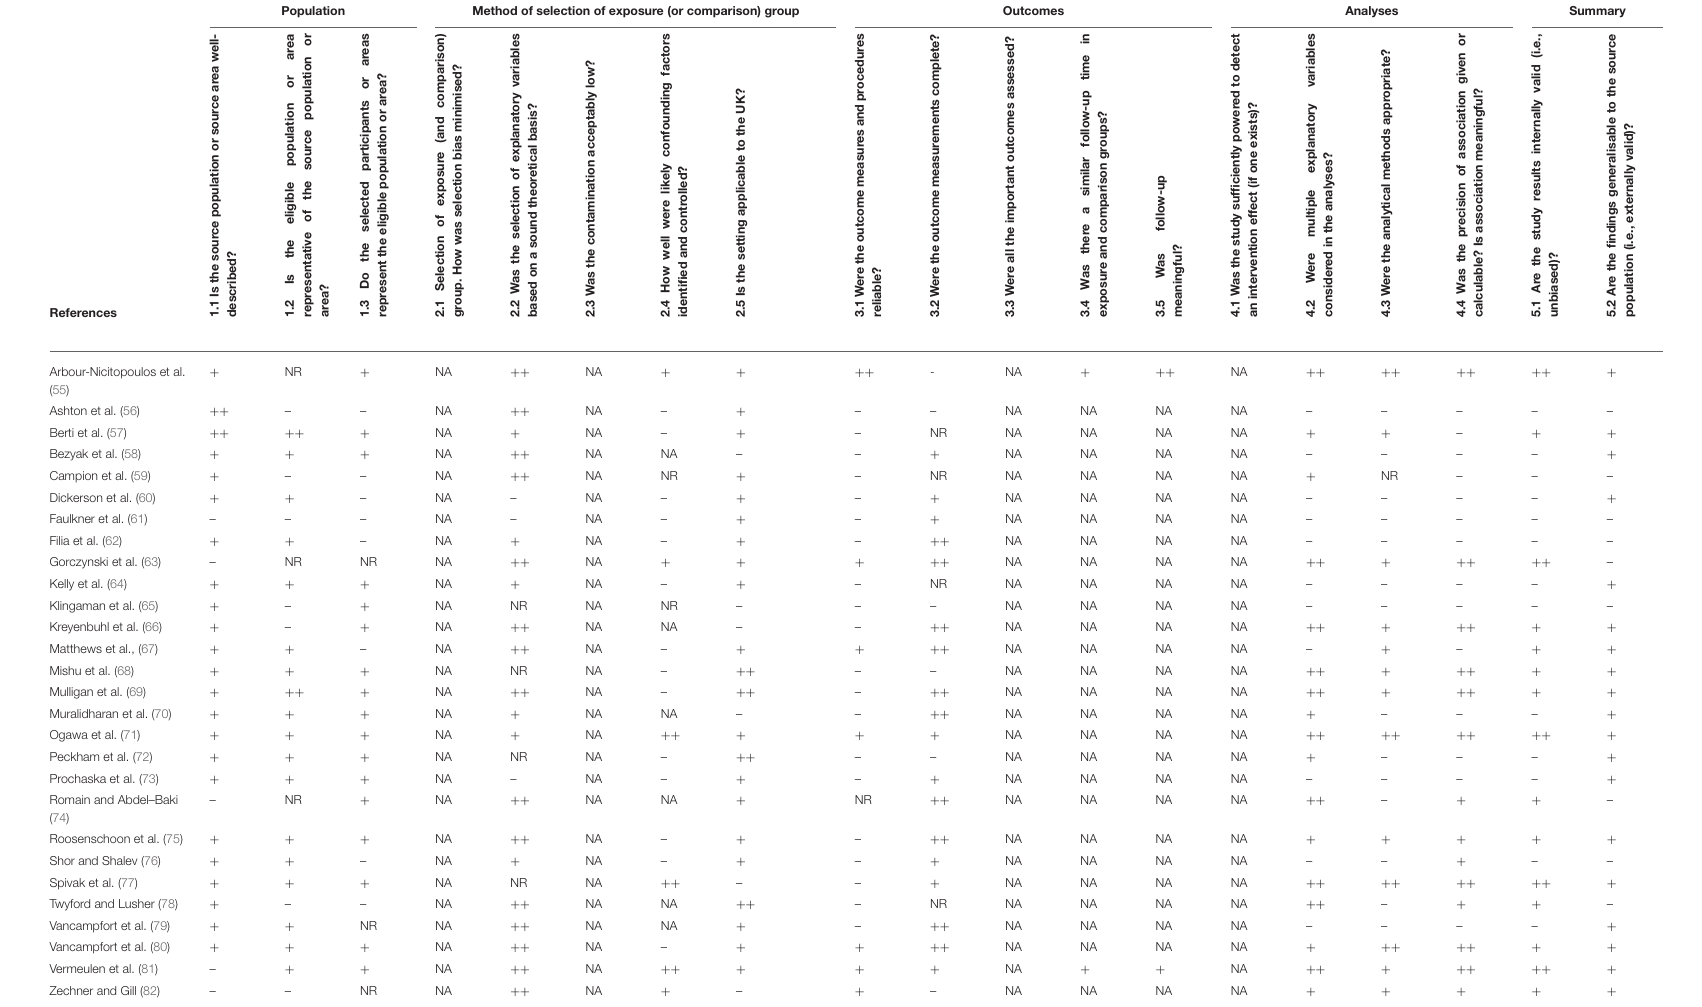
TABLE 6 | Quality appraisal ratings for individual studies. Population Methodofselectionofexposure(orcomparison)group Outcomes Analyses